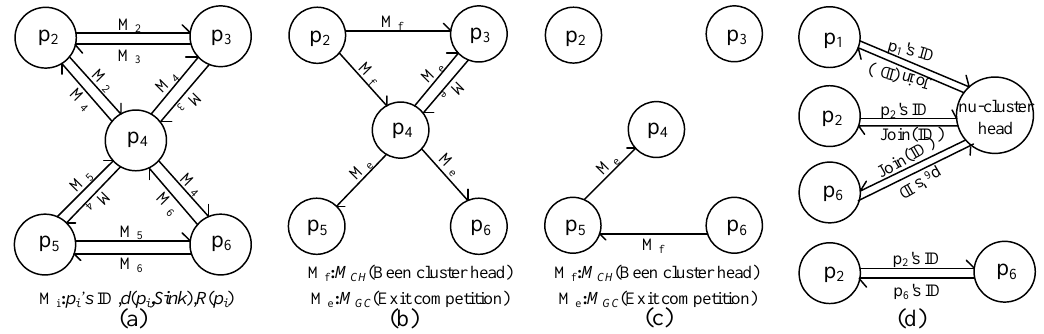
Figure 7. ( a ) Message flow in the initialization phase of cluster head node competition; ( b , c ) message flow at the stage of cluster head node competition; ( d ) message flow after cluster head node competition.